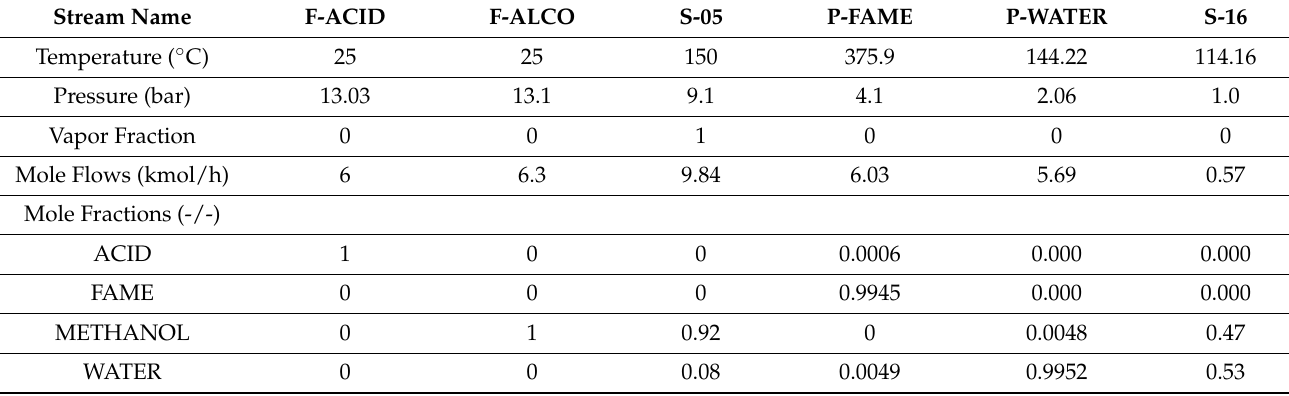
Figure 3. Detailed schematic of RD process. Table 3. Stream results of the biodiesel